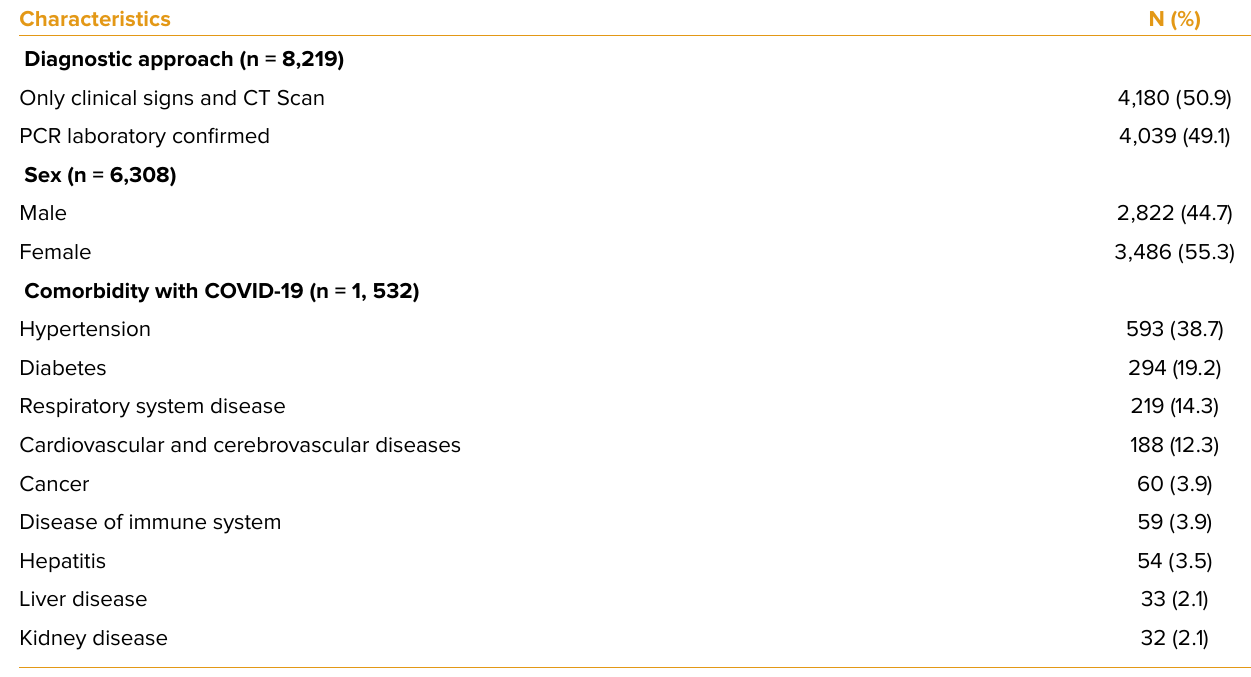
Table 1. Demographic and clinical characteristics of COVID-19 infection included in the reviewed studies